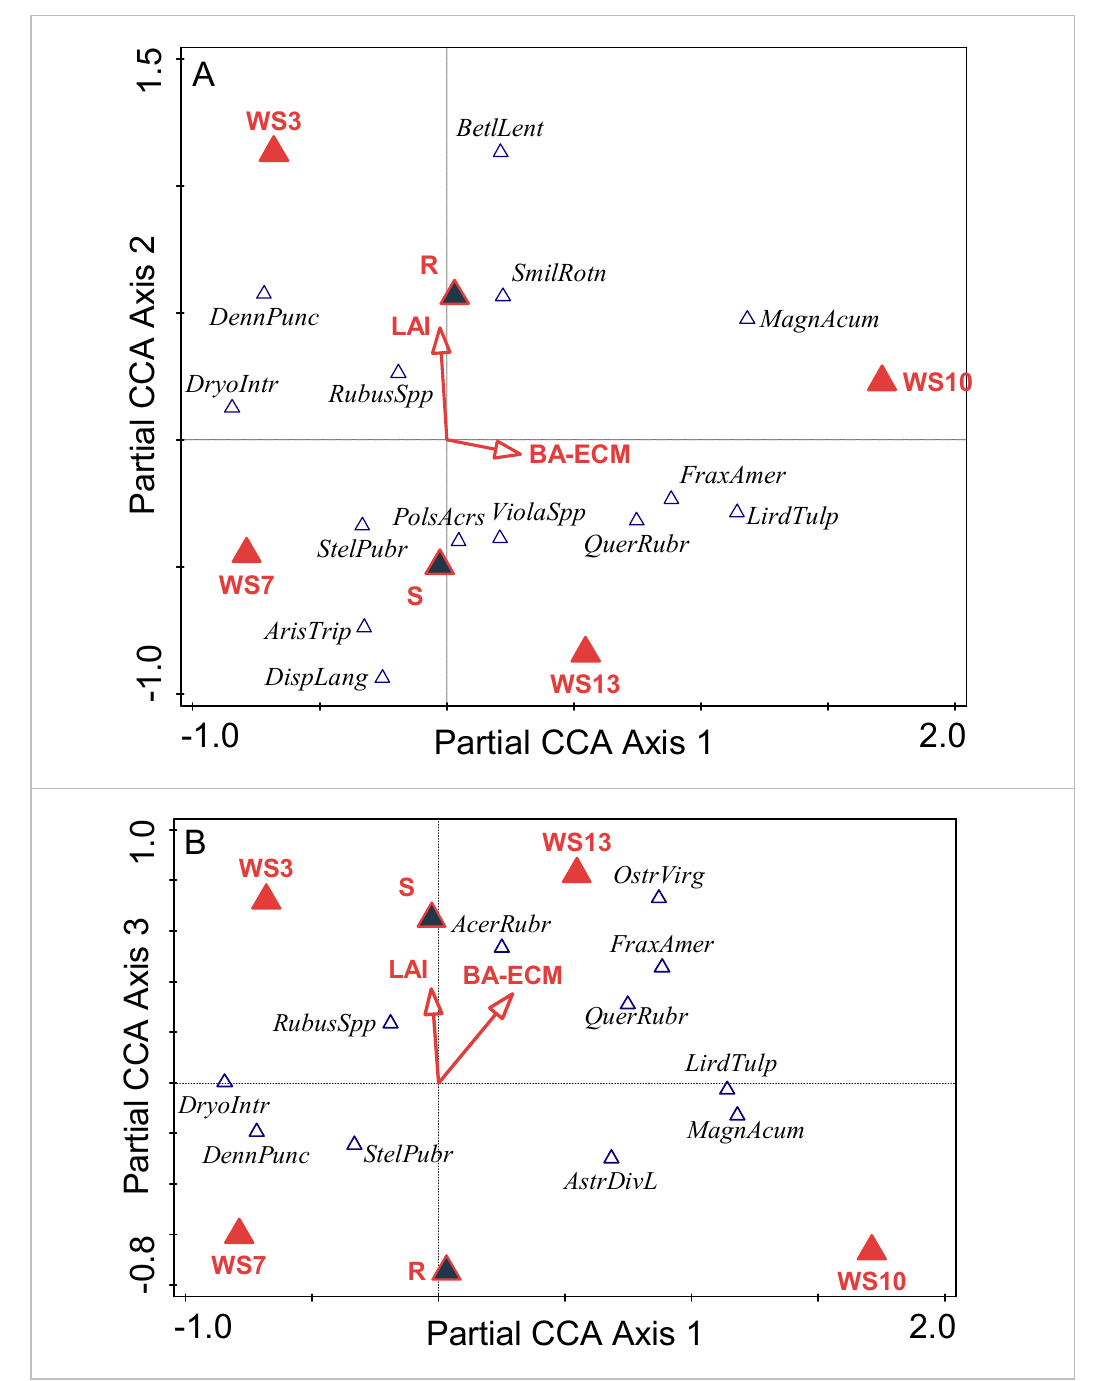
Figure 5. Ordination diagrams of a partial canonical correspondence analysis (CCA), plotting ( A ) Axis 1 against Axis 2 and ( B ) Axis 1 against Axis 3, of summer 2018 herb-layer species in relation to environmental factors and variables at Fernow Experimental Forest, West Virginia, USA. Covariates in this analysis were physical attributes of the plots (e.g., slope angle, aspect, and slope position [i.e., distance to stream]). Shown are only species that occurred in at least seven of the 72. plots and that have >5% correlation with each axis. Species are plotted at their optimum positions along each of the ordination axes with their abundances decreasing symmetrically in all directions. Symbols of environmental variables (solid triangles for each watershed (WS) and the two maple species—red maple (R), sugar maple [S]) represent a level of factors Watershed and plot-center Maple, respectively, i.e., each symbol can be interpreted as representing a group of plots (e.g., R represents all plots under red maple, WS10 represents all plots of WS10) [62] .